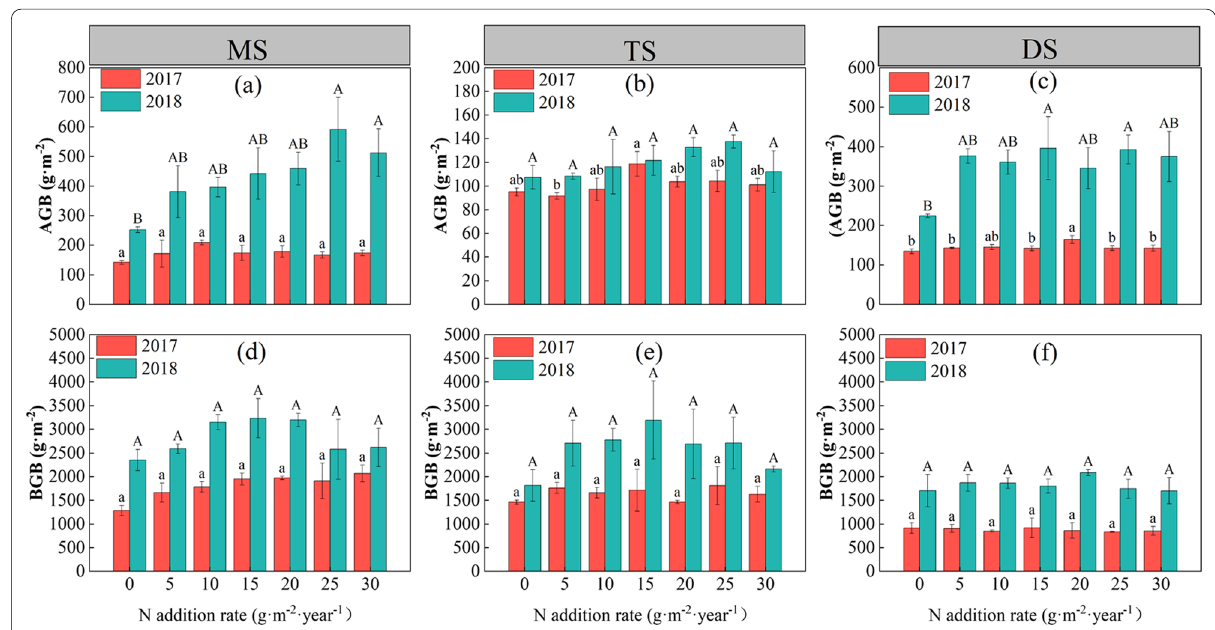
Fig. 2 Effect of experimental N addition on above- (( a ) MS, ( b ) TS, ( c ) DS) and below-ground biomass (( d ) MS, ( e ) TS, ( f ) DS) of three temperate steppes from 2017 to 2018. Lowercase letters represent significant differences among different treatments in 2017 at the 0.05 level, while uppercase letters represent significant differences among treatments in 2018 at the 0.05 level. Data show the mean